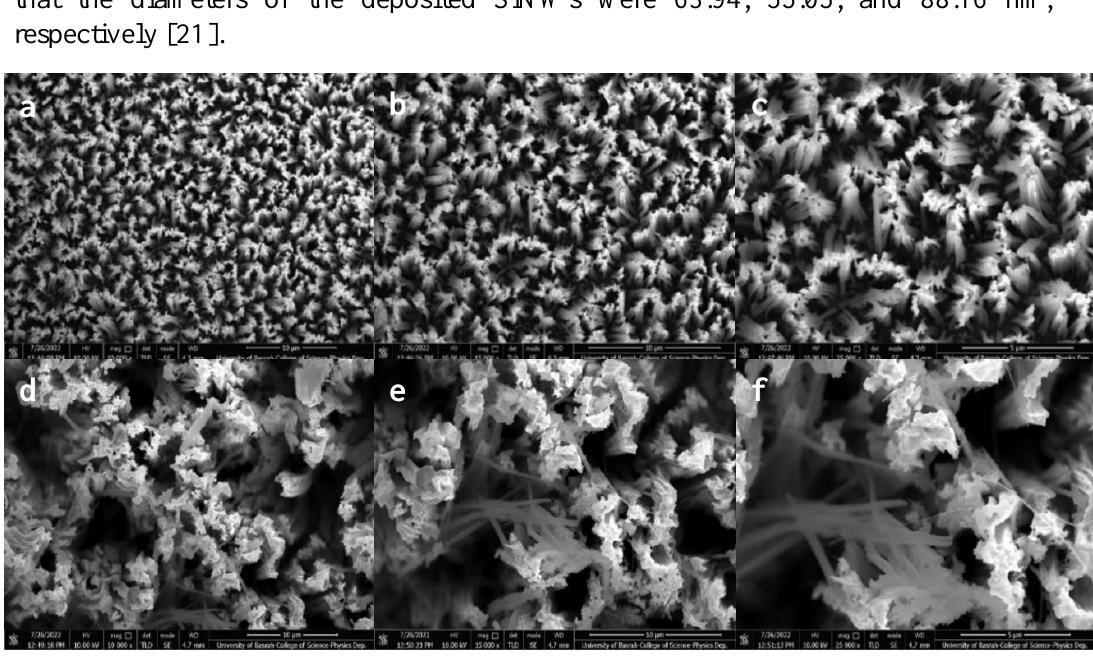
Figure 2: FESEM images of p-SiNWs grown etching time of (a) (Mag. = 10.000 K X), (b) (Mag. = 15.000 K X) and (c) (Mag. = 25.000 K X) for 15 min., (d) (Mag. = 10.000 K X) (e) (Mag. = 15.000 K X), and (f) (Mag. = 25.000 K X) for 30